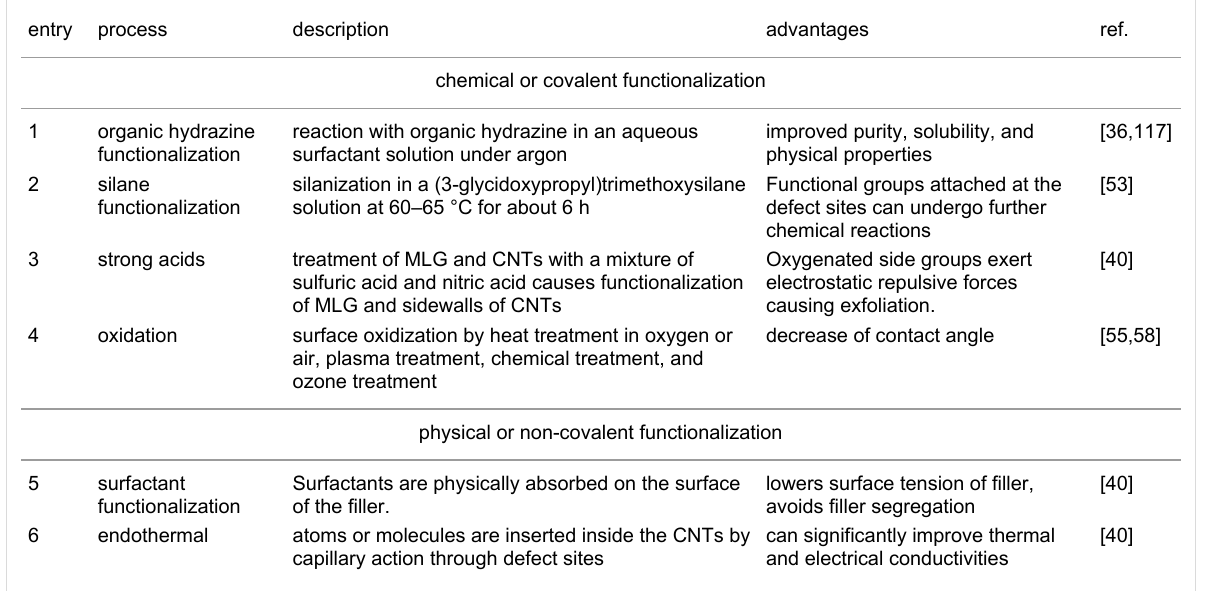
Table 2: Functionalizations of CNTs and MLG.